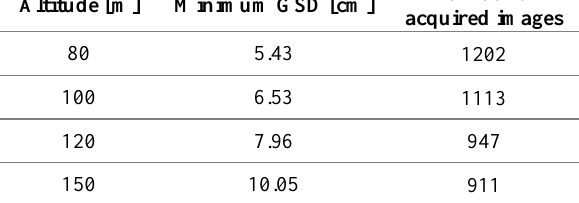
Table 1 Specifics of the acquisition campaign; the minimum (theoretical) GSD has been computed based on the altitude and the camera